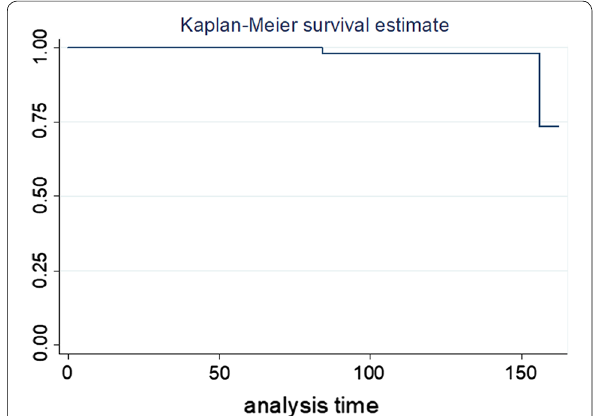
Fig. 1 Kaplan–Meier analysis of implant survival probabilities, counting revision of any components for any reason as the terminating event or at the end of the follow-up period